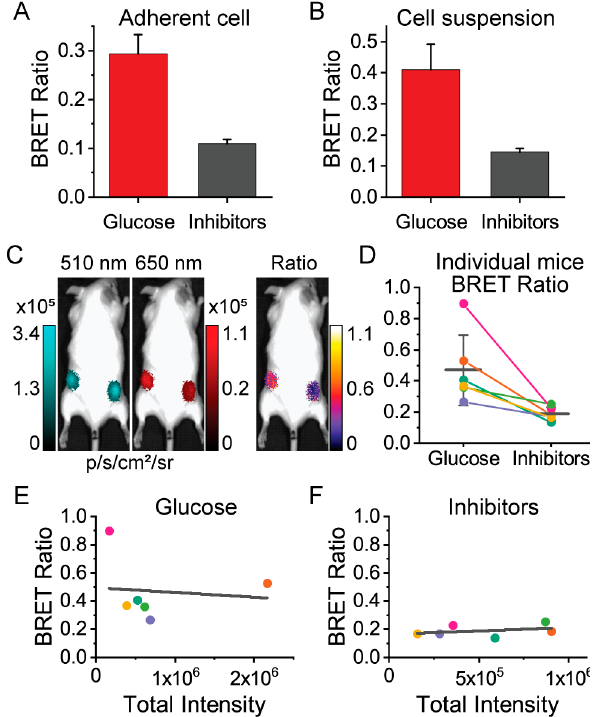
Figure 5. The ARSeNL BRET ratio reports differences in energy metabolism in live cells when imaged through tissue and fur and does not depend on sensor expression levels. The mScarlet/NanoLuc BRET ratio reports differences in ATP levels in ( A ) adherent HEK293A cells treated with glucose or an inhibitor cocktail of 2DG and oligomycin A (mean ± sd, n = 6, p < 0.001) or ( B ) live-cell suspensions treated with glucose or inhibitors (mean ± sd, n = 5, p < 0.001). ( C – F ) Whole-animal imaging of unshaved adult FVB mice injected with cell suspensions ( n = 6). ( D ) Colored circles and lines connect glucose- and inhibitor-treated cells for individual mice. The black horizontal line and error bars are the populations mean ± sd ( p = 0.013). There is no correlation between BRET ratio and total luminescence intensity (expression level) in the presence of glucose ( E ) R 2 = 0.01 or inhibitors ( F ) R 2 = 0.12.